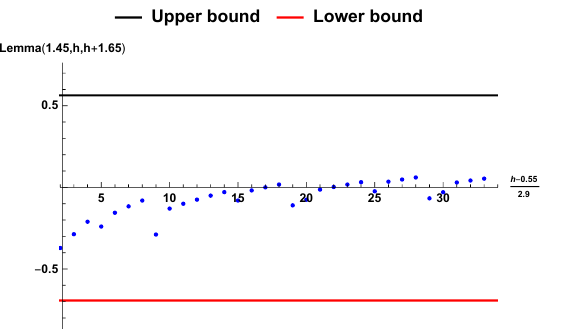
(cid:20) (cid:18) (cid:19)(cid:21) q 1 c (cid:22) h Q h; (cid:22) (cid:12) = (cid:25) (cid:0) 2 (cid:14) 6